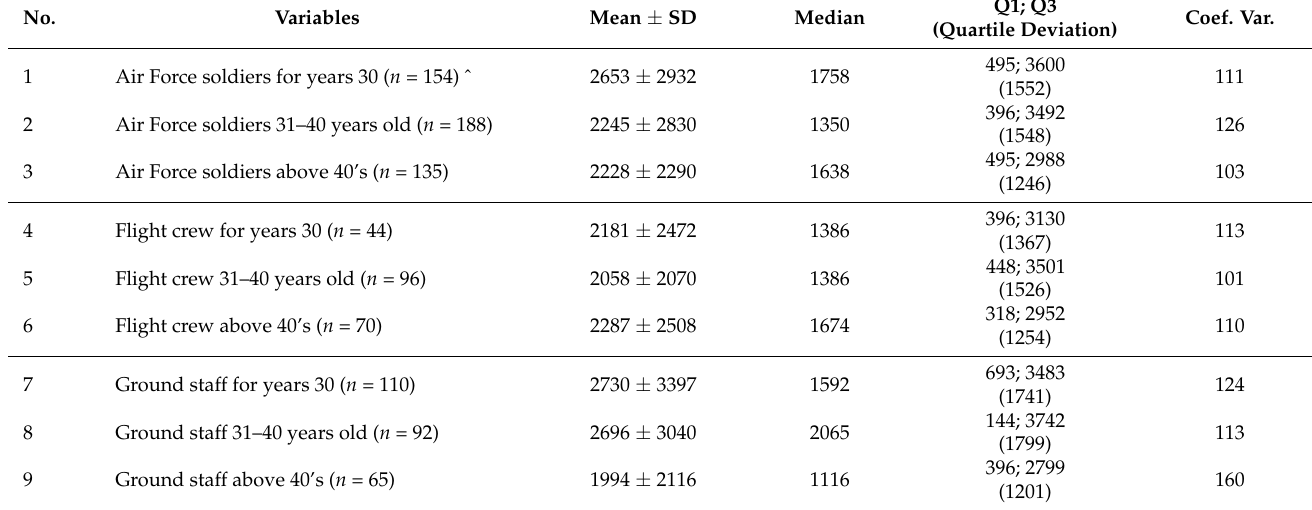
Table A3. Summary of total MET related to relocate in different groups.